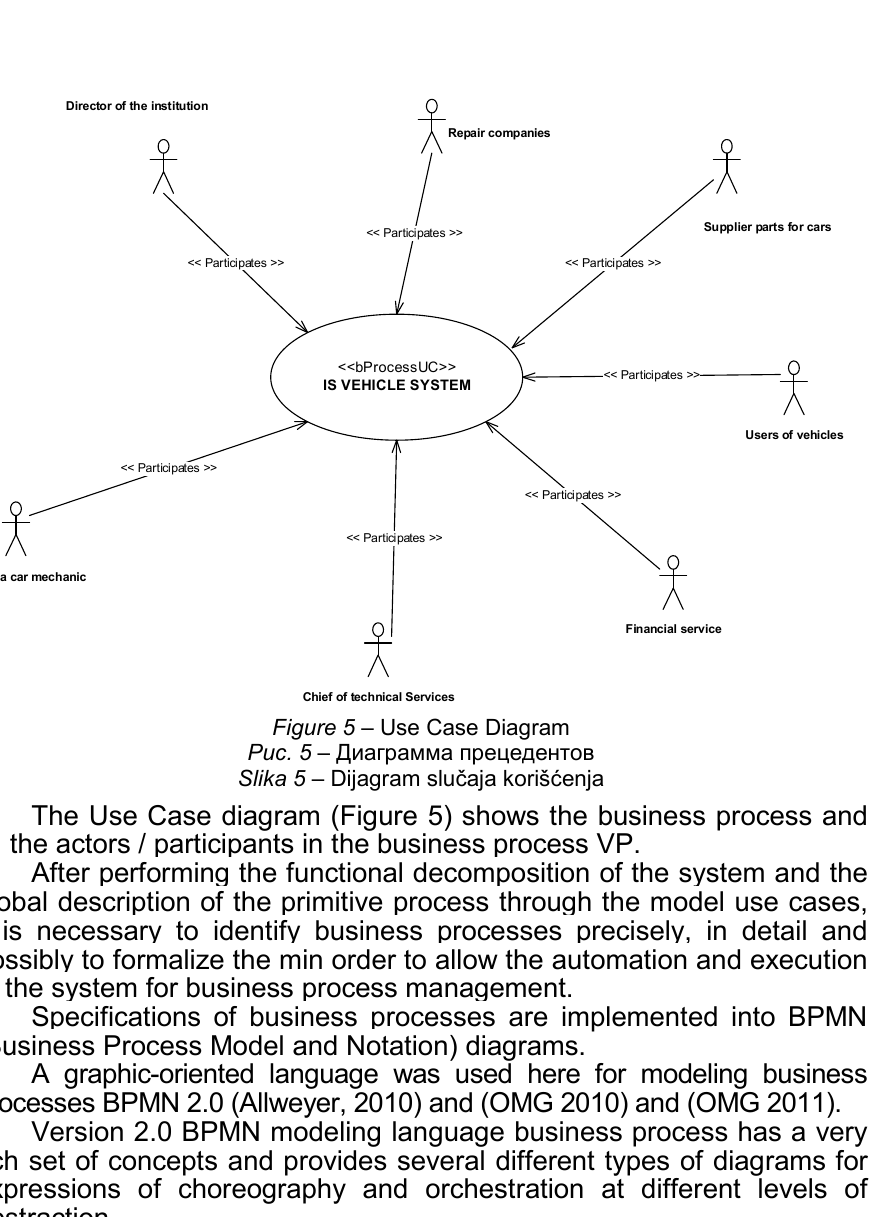
Figure 5 – Use Case Diagram Рис . 5 – Диаграмма